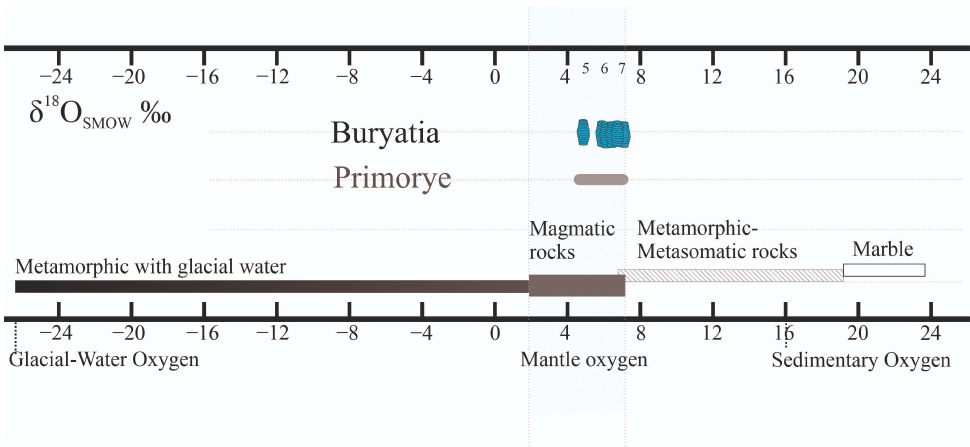
Figure 14. Isotopic composition of corundum of various genesis. Adapted with permission from [38] using [5,10,11,24–26,31,35,39,40]. Naryn-Gol—this study.